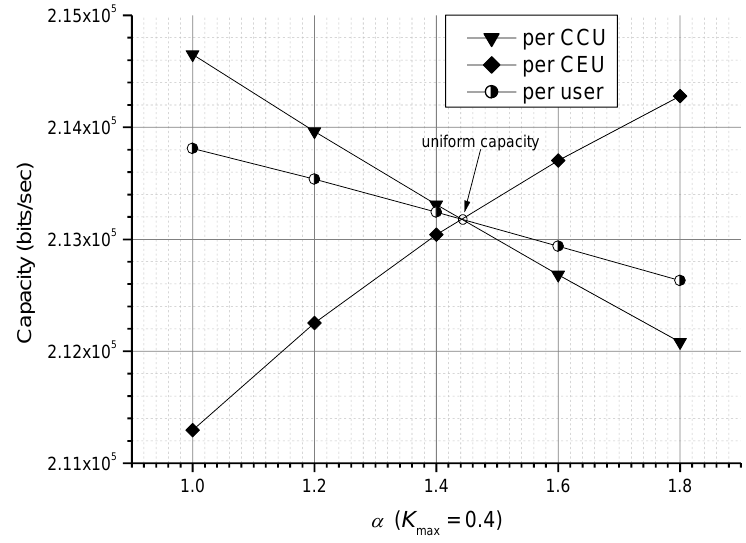
Figure 5. Capacity comparison as a function of 𝛼 for a large 𝐾 max (= 0.4) in SU-network MIMO.